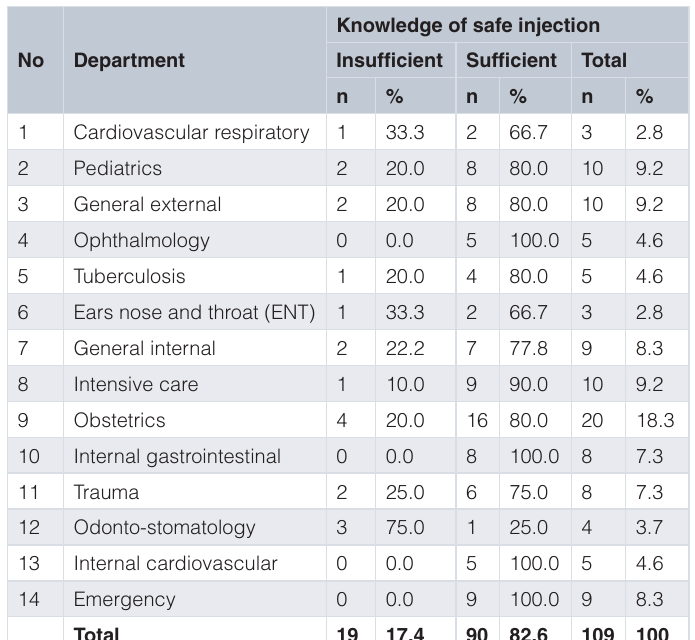
Table 2. Knowledge of injection safety of nurses by department.